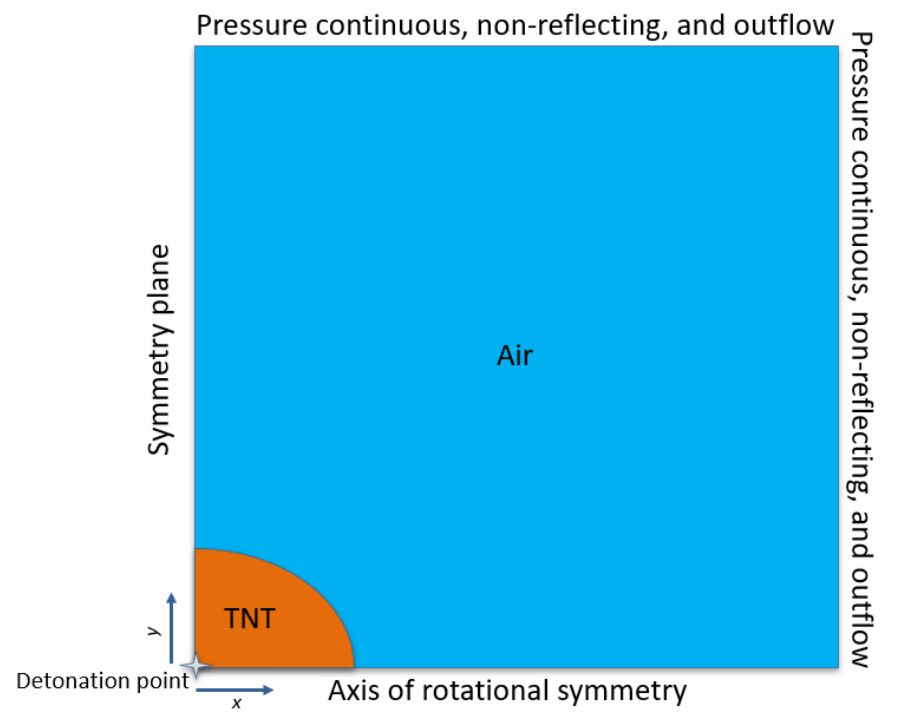
Figure 1. A “cartoon” depiction of the setup of the free-field TNT detonation simulations with materials and boundary conditions labeled (Not to